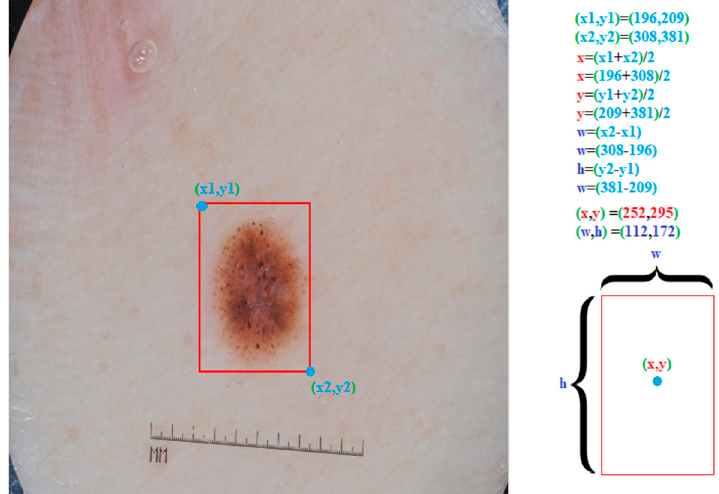
Figure 4. Labeling a skin lesion image for the training of Yolov3. The upper left corner coordinates (x1, y1) and the bottom right corner coordinates (x2, y2) of bounding box was were used for determining of the bounding box x, y, w, and h values.